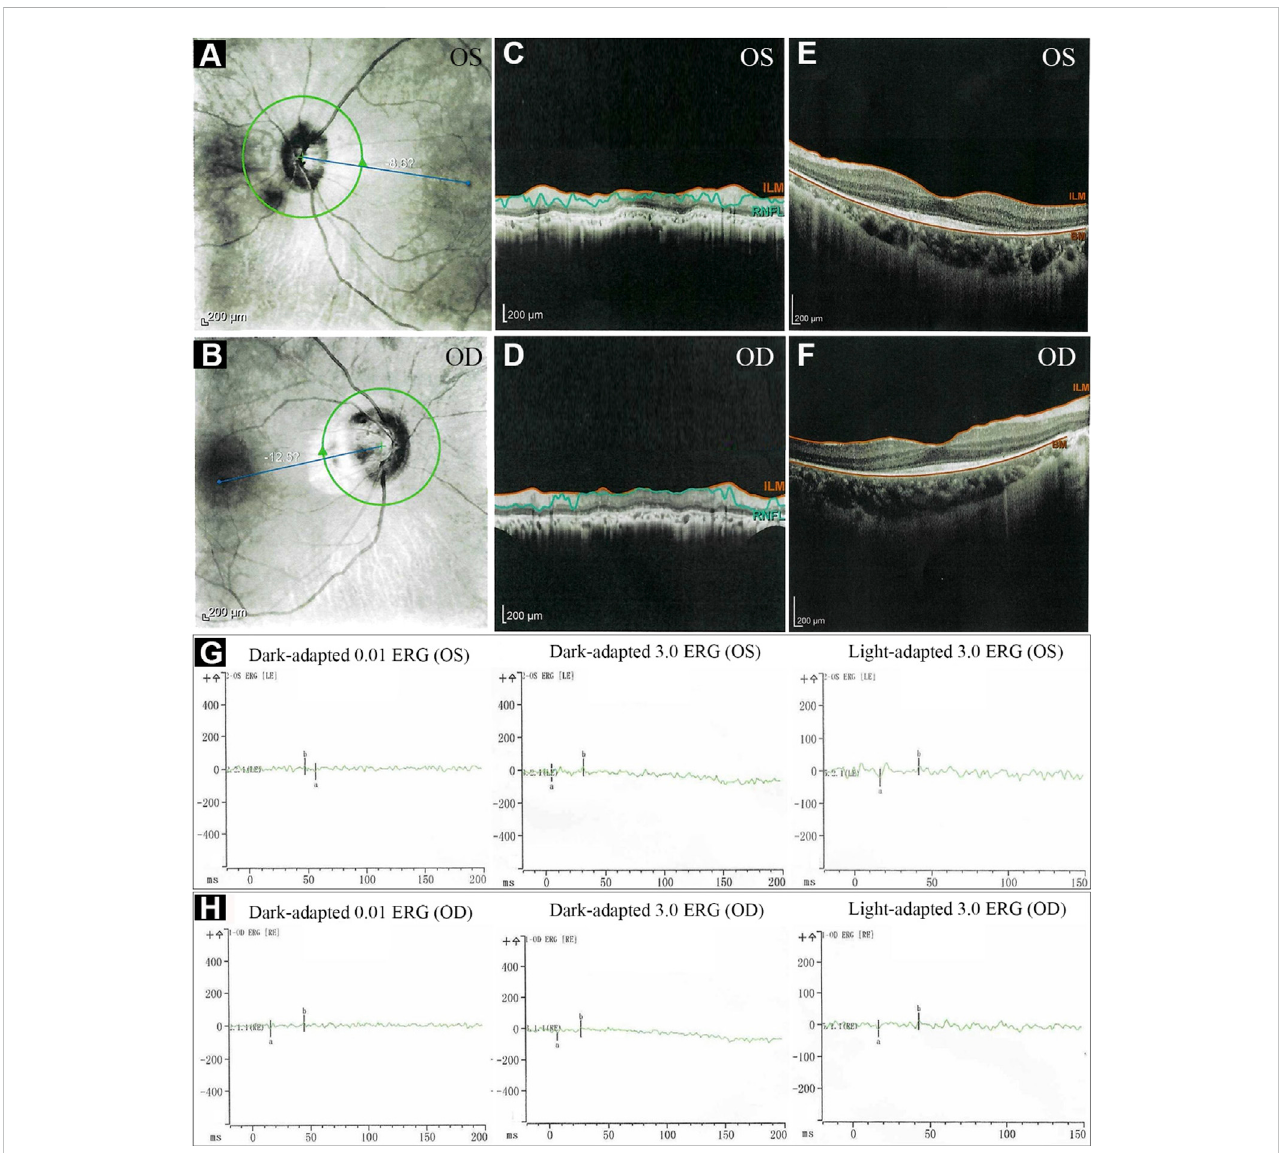
FIGURE 2 The optical coherence tomography (OCT) and electroretinography (ERG) of the proband. (A – F) OCT showed thinning of retinal nerve fi ber layer. (G, H) ERG showed signi fi cantly reduced scotopic and photopic responses, with extinguished decrease of a and b waves. ILM, internal limiting membrane; RNFL, retinal nerve fi ber layer; BM, Bruch ’ s membrane; OS, oculus sinister (left eye); OD, oculus dexter (right